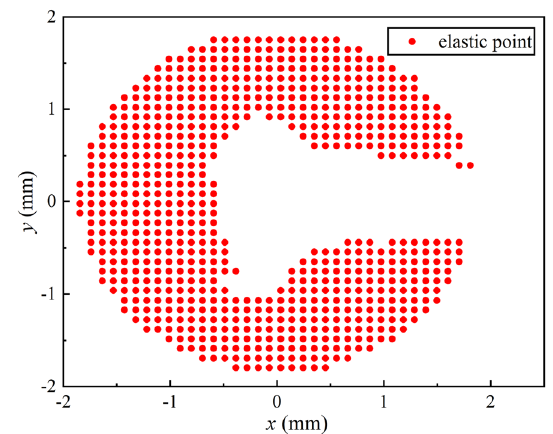
Figure 7 Elastic region used for crack tip parameter